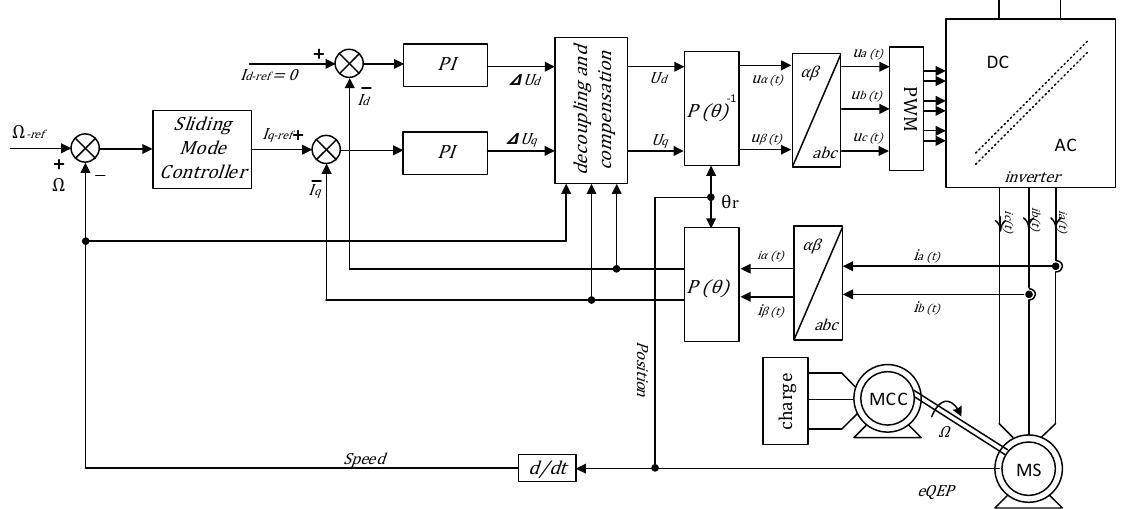
Figure 1. Overall block diagram of the proposed control